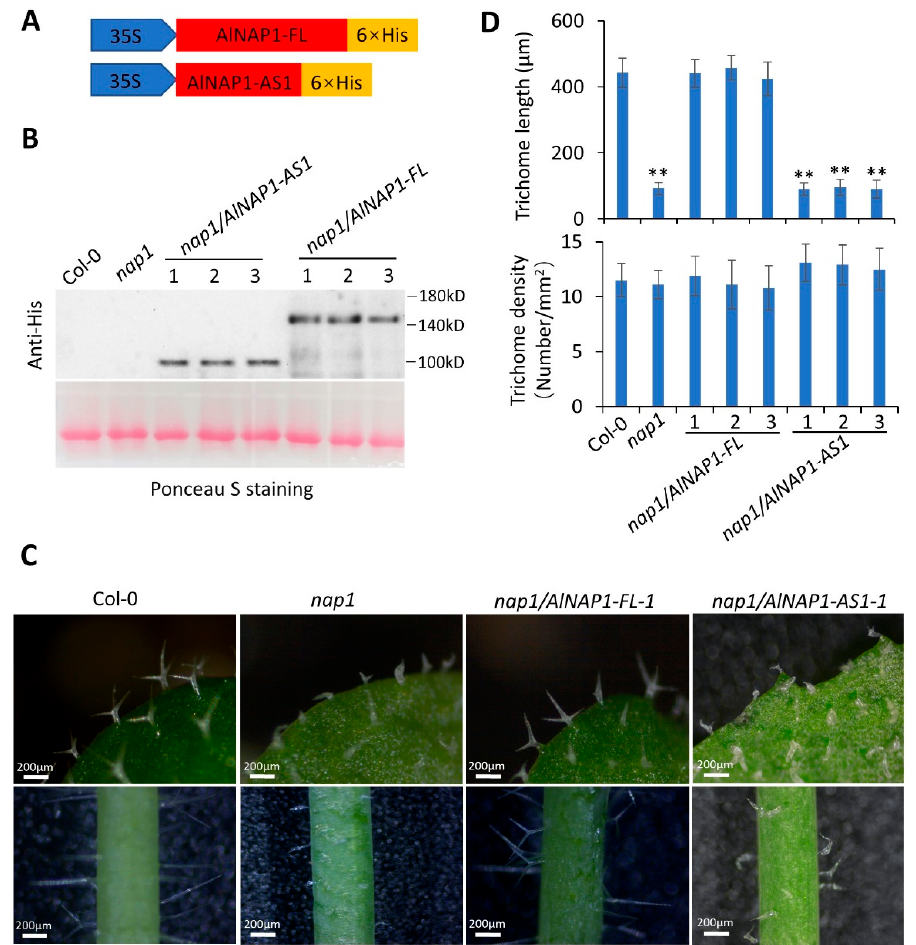
Figure 5. The complementation of nap1 mutant was achieved by AlNAP1-FL but not AlNAP1-AS1 . ( A ) The constructs of vector overexpressing AlNAP1-FL and AlNAP1-AS1. ( B ) Western-blot analysis of Col-0, nap1 mutant, three independent transgenic lines of nap1/AlNAP1-AS1 and nap1/AlNAP1-FL by using anti-His antibodies. ( C ) The observation of leaf and stem trichomes of Col-0, nap1 mutant, nap1/AlNAP1-AS1-1 , and nap1/AlNAP1-FL-1 . ( D ) Trichome length and density of leaves of Col-0, nap1 mutant, nap1/AlNAP1-AS1 , and nap1/AlNAP1-FL . More than 20 trichomes for each line were measured and showed in the mean values ± SD. Significant differences were determined by Student’s t -test (** indicates p < 0.001).